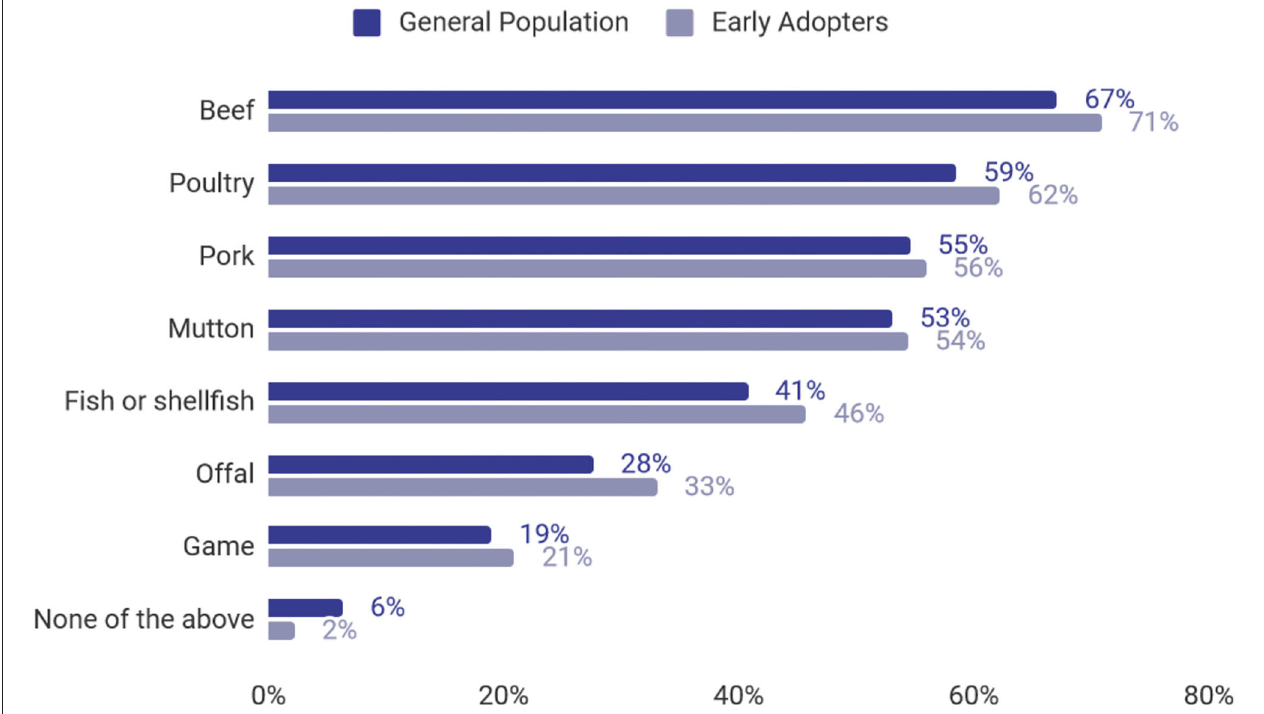
FIGURE 14 | Appeal of cultivated meat